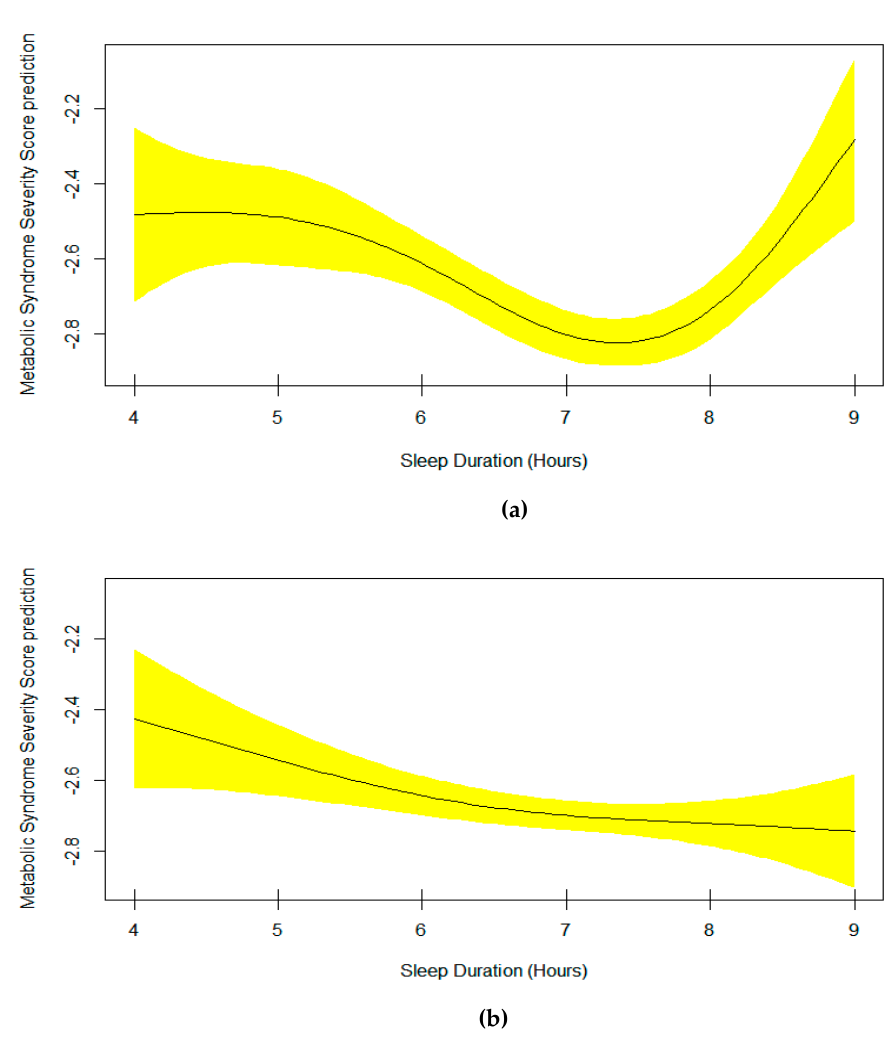
Figure 5. E ff ect modification of sex and sleep duration in the multivariable generalized additive model 5 when the response variable was the metabolic syndrome severity score. ( a ) EDF was 3.43 ( p = 0.00002) in the female model (upper plot), ( b ) EDF was 1.76 ( p = 0.04) in the male model (lower plot).